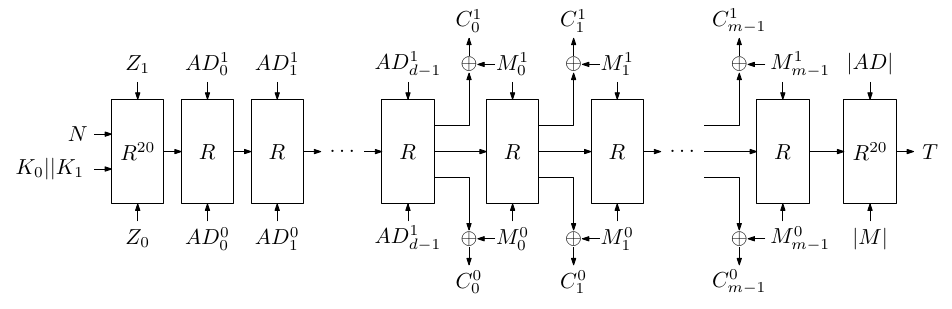
Figure 2: The procedure of